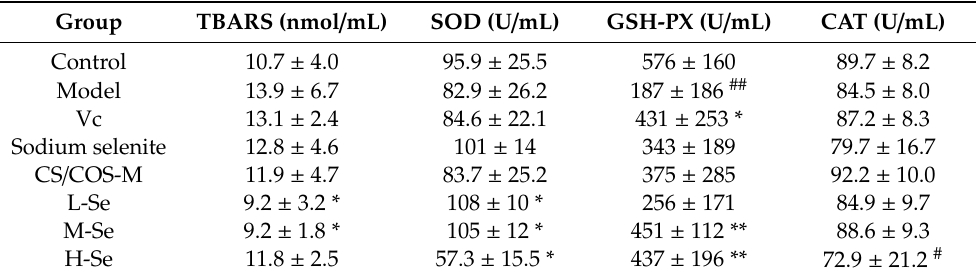
Table 6. Serum biomarkers of KM mice ( n = 10).